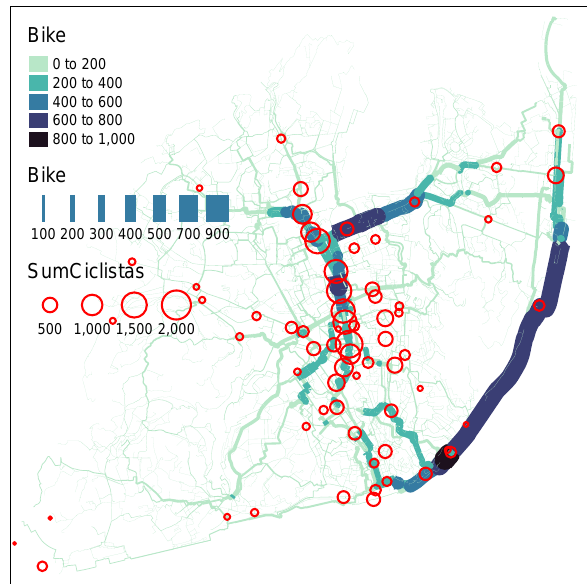
Figure 9. Route network from jittered desire lines with disagregation of 200 trips, with routes from r5r, level of traffic stress 2 (quiet) routing option.